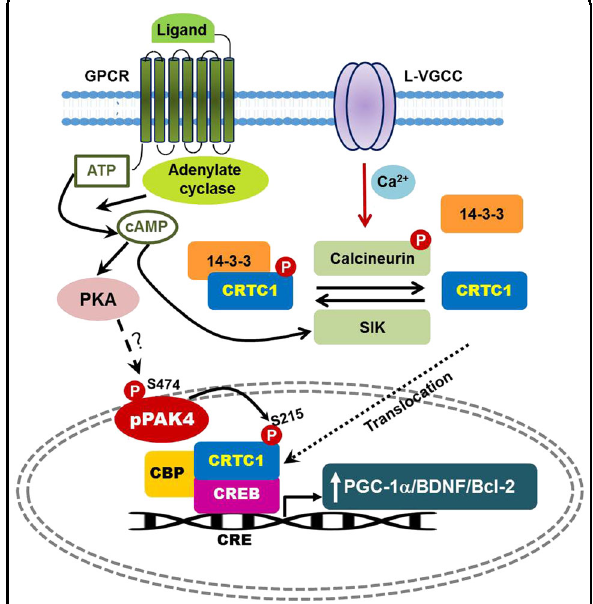
Fig. 4 PAK4-mediated signaling pathways in PD. In the cytosol, CRTC1 is phosphorylated at S151 by the cAMP-SIK pathway and is inactivated through interactions with 14 – 3 – 3 proteins 12 . Ca 2 + in fl ux through L-type VGCCs stimulates calcineurin-dependent CRTC1 dephosphorylation 12 . CRTC1 is activated by calcineurin-dependent dephosphorylation 12 . Dephosphorylated CRTC1 is translocated to the nucleus, where it is likely phosphorylated at S215 by PAK4, which triggers CREB-mediated transcription. In PD, oxidative stress and aggregated α -Syn decrease PAK4 activity and reduce pCRTC1 S215 levels, which subsequently decrease the expression of CREB target genes such as BDNF, Bcl-2, and PGC-1 α , leading to dopaminergic neuron death. CRE, cAMP response element; CREB CRE-binding protein, CRTC1 CREB-regulated transcription coactivator 1, CBP CREB- binding protein, SIK1 salt-inducible kinase 1, VGCC voltage-gated calcium channel, BDNF brain-derived neurotrophic factor, Bcl-2 B-cell lymphoma 2, PGC-1 α peroxisome proliferator-activated receptor gamma coactivator 1 alpha, TH tyrosine